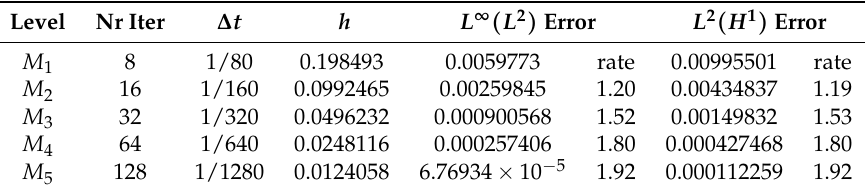
Table 3. L ∞ ( L 2 ) and L 2 ( H 1 ) errors and rates for the modified Leray- α model. The final time is T = 0.1. The predicted rate order is 2.